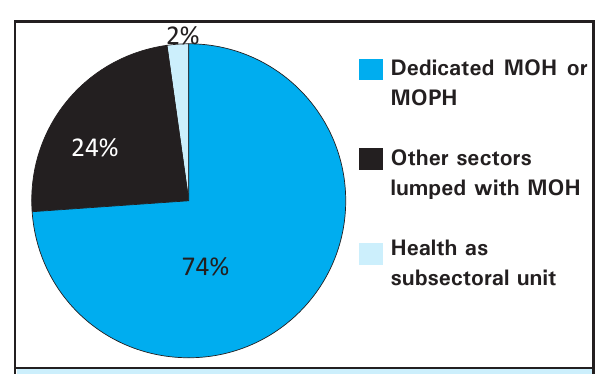
Figure 2. Type of MOH in Who member states.